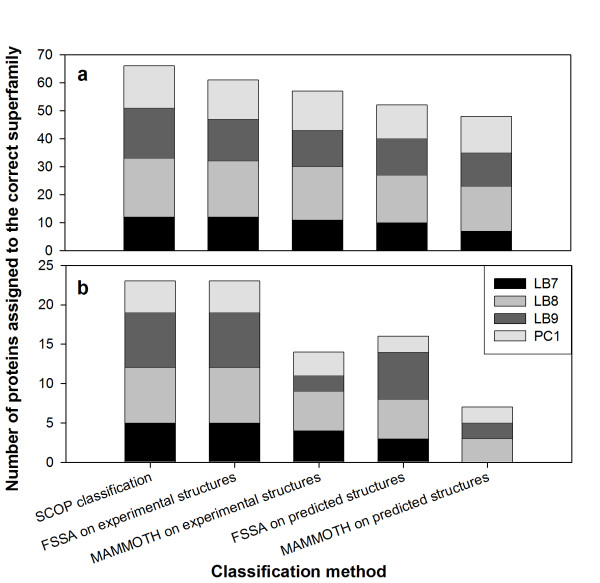
Comparison of function classification performance by FSSA and MAMMOTH on experimental and predicted structures. These structures correspond to selected prediction targets from the LiveBench 7 (LB7), LiveBench 8 (LB8), LiveBench 9 (LB9) and PDB-CAFASP 1 (PC1) experiments. (a) represents those prediction targets that are assigned to the correct SCOP fold (regardless of superfamily) by 3D-Jury; (b) represents those prediction targets that are assigned to the correct SCOP fold but incorrect SCOP superfamily by 3D-Jury. The heights of the first bars ("SCOP classification") in panel (a) and (b) correspond to the total number of targets to be classified for each panel, while the following bars represent the number of targets assigned to correct superfamily by the corresponding prediction methods. The FSSA algorithm has better performance than the structure comparison method for both experimental and predicted structures, and especially for predicted structures that were generated with biases towards the incorrect functional categories.